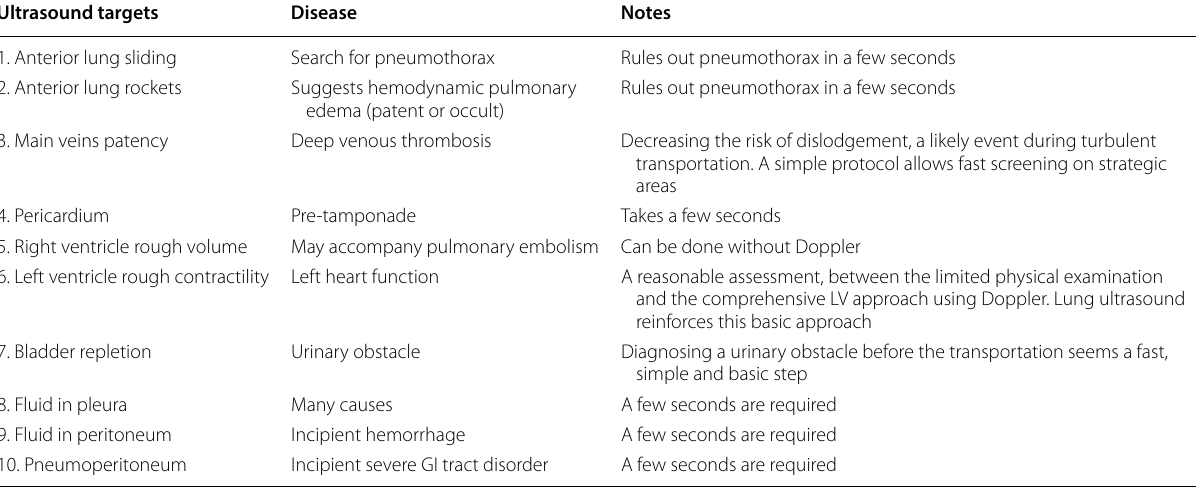
Table 1 The ten targets of our ultrasound protocol which follow the physical examination of a patient before an emergency airborne